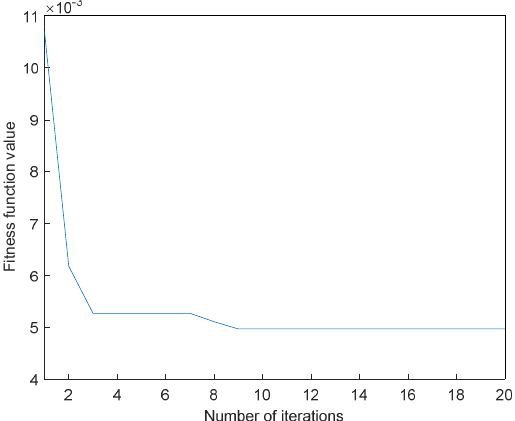
Figure 9. The fitness function varies with the number of iterations.